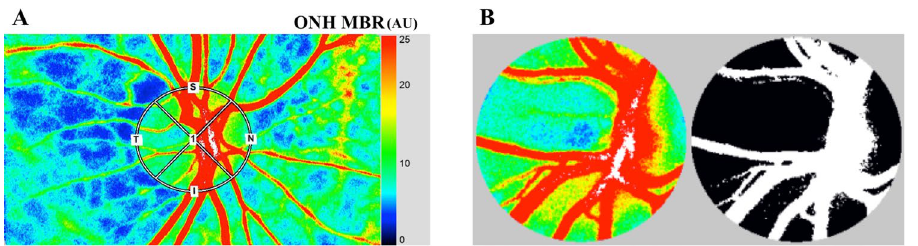
Figure 5. Representative composite color maps used to determine the mean blur rate (MBR) recorded by laser speckle flowgraphy (LSFG). The red color indicates a high MBR and the blue color indicates a low MBR. To measure the MBR on the optic nerve head (ONH), a circle was drawn around the ONH ( A ). A binary format image for segmentation between the vessel (white area) and tissue (black area) areas on the ONH ( B